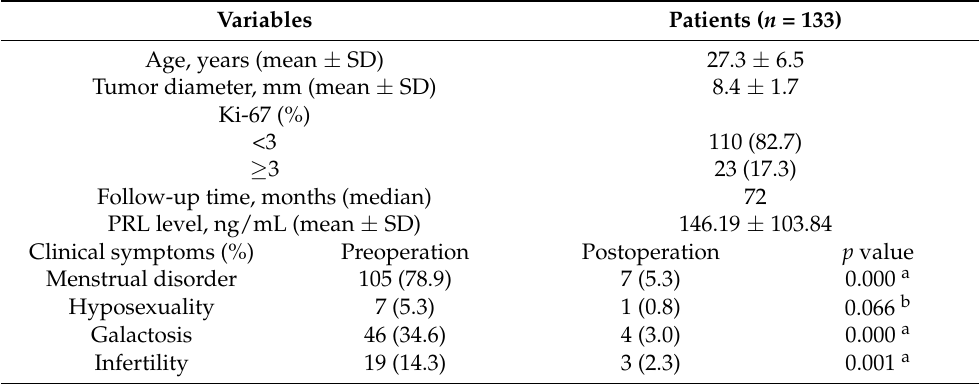
Table 2. Baseline characteristics of 133 female patients with